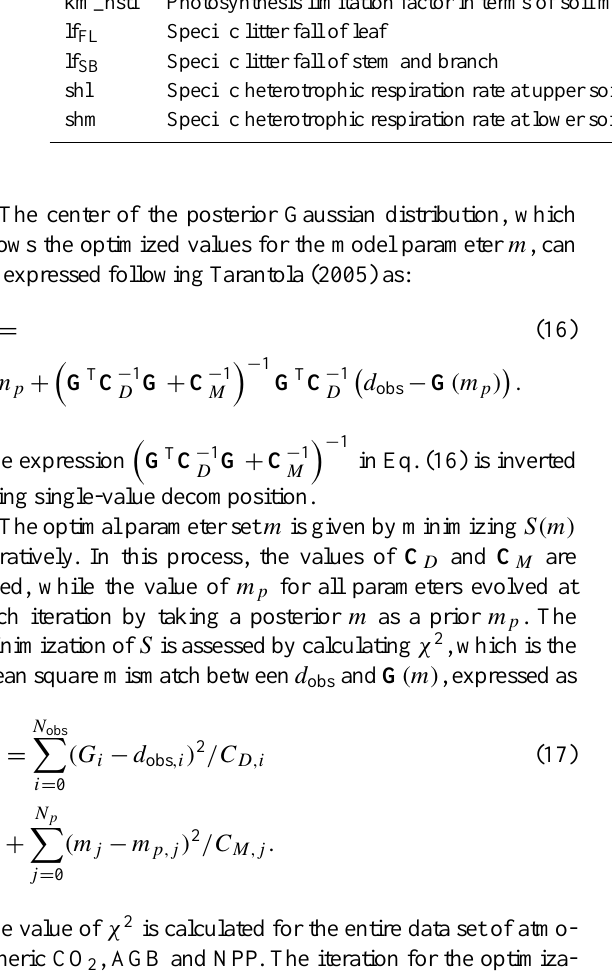
Table 1. List of variables in prior parameters (Prior) and their uncertainties (Unc). The values given in parentheses are for grassland. Symbol Parameter description (unit) Prior Scale Unc Scale P max Q 10 Temperature dependence of respiration rate (dimensionless) Specific leaf area (cm 2 g − 1 ) T min Minimum temperature for plant activities ( ◦ C) T opt Optimum temperature for plant activities ( ◦ C) TP FL Carbon translocation rate to foliage (dimensionless) km_nstl Photosynthesis limitation factor in terms of soil moisture lf FL Specific litter fall of leaf lf SB Specific litter fall of stem and branch shl Specific heterotrophic respiration rate at upper soil shm Specific heterotrophic respiration rate at lower